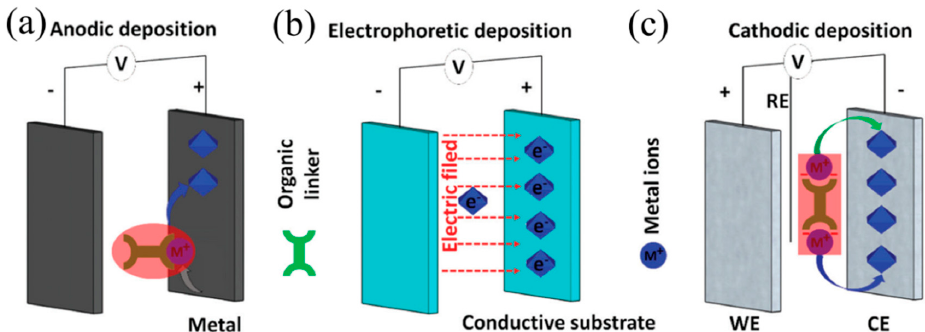
Figure 8. Schematic representation of the electrochemical synthesis of MOF thin films with ( a ) anodic deposition; ( b ) electrophoretic deposition and ( c ) cathodic deposition. Reprinted with permission from Reference [41]. Copyright 2017 the Royal Society of Chemistry, (London, UK).